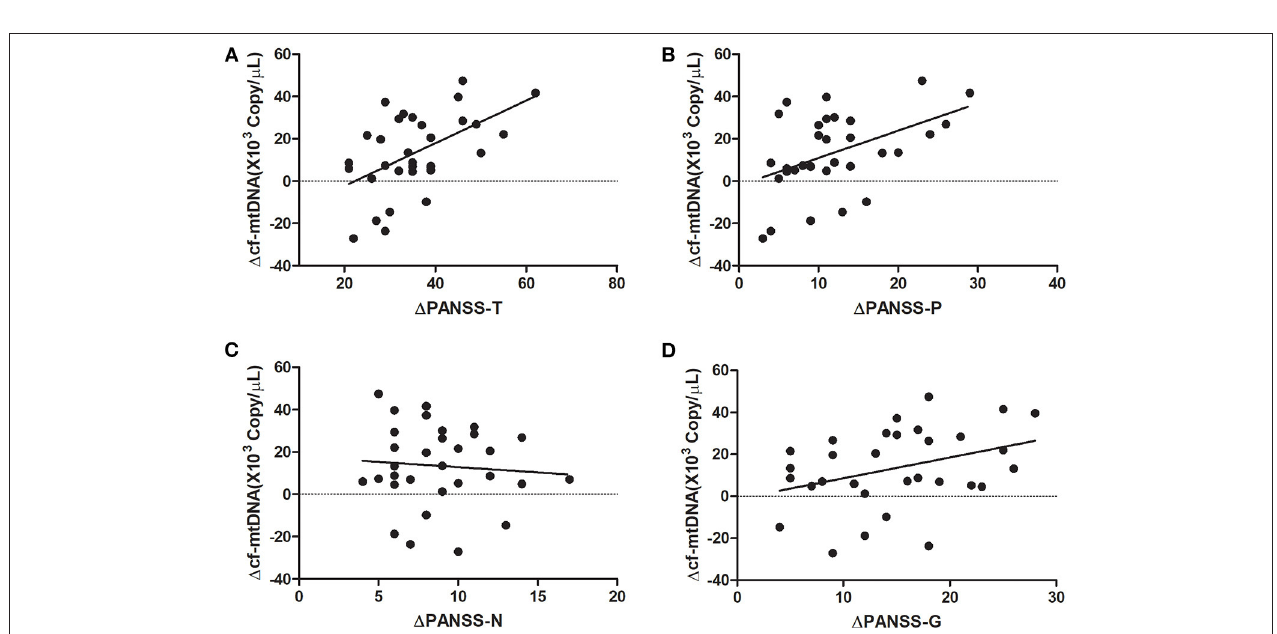
FIGURE 3 | Correlation analysis of the copy number changes in the plasma cf-mtDNA ( 1 cf-mtDNA) with components of the PANSS scores in first-episode patients with schizophrenia (after 8 weeks of antipsychotic treatment). (A) r = 0.53, P = 0.002; (B) r = 0.46, P = 0.01; (C) r = − 0.08, P = 0.66; (D) r = 0.35, P = 0.055.